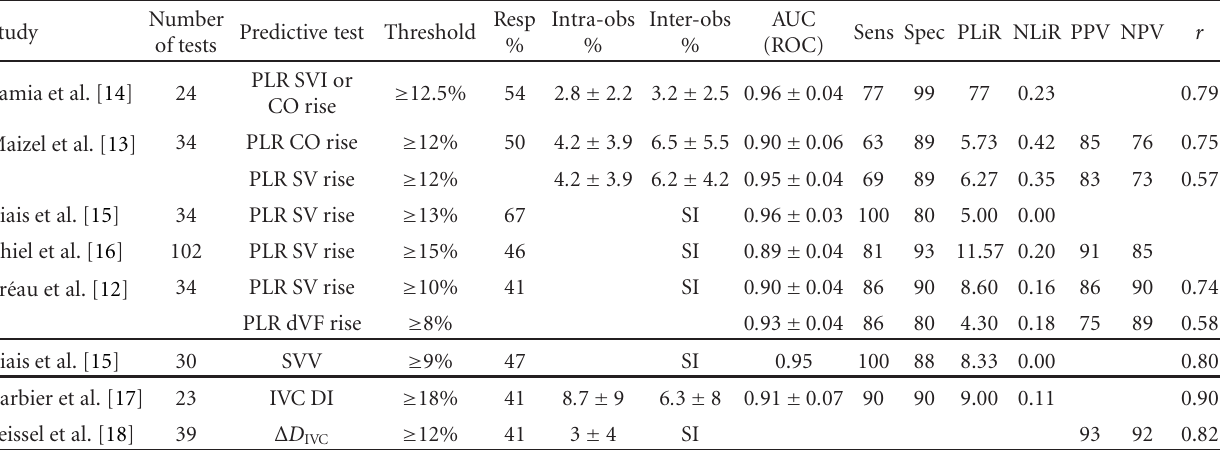
Table 3: Collated results of all included